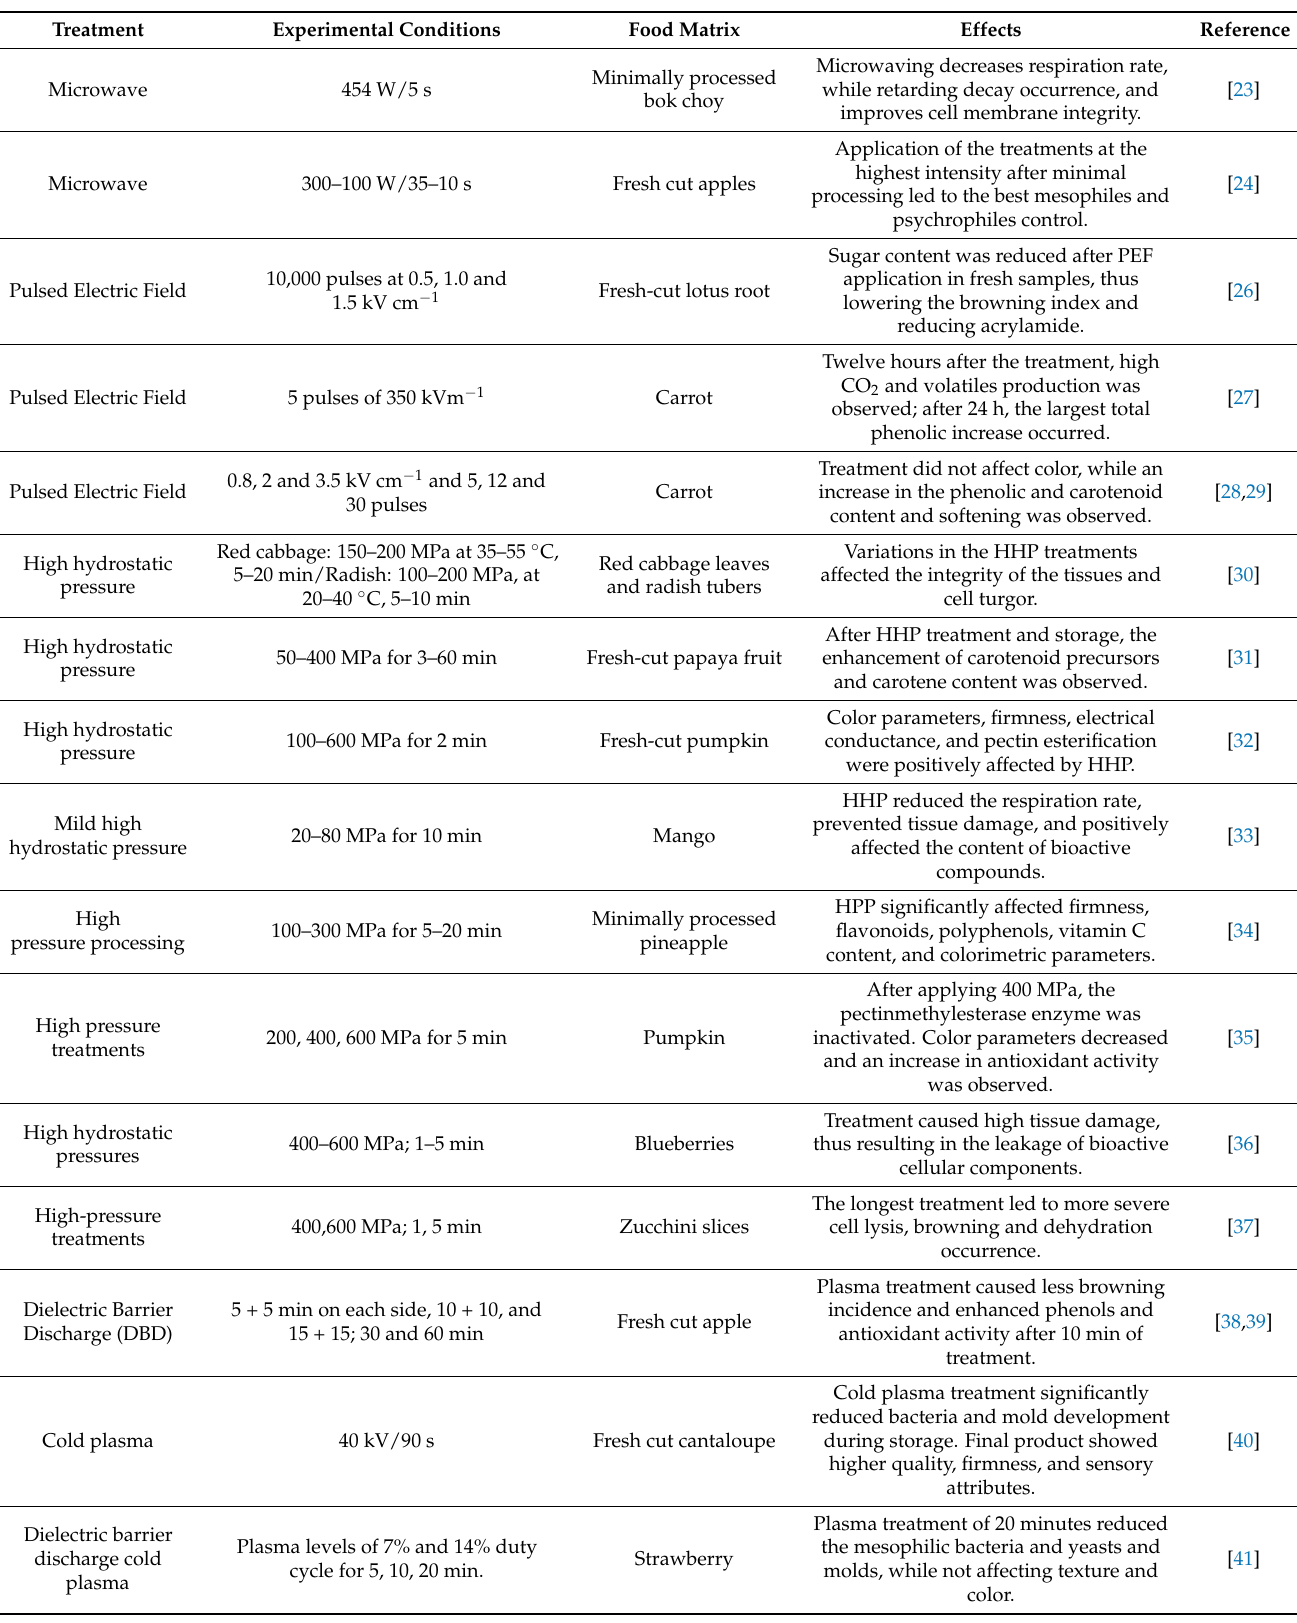
Table 1. The main applications of emerging physical postharvest treatments on fresh and minimally processed horticultural products, as reported in research published over the last five